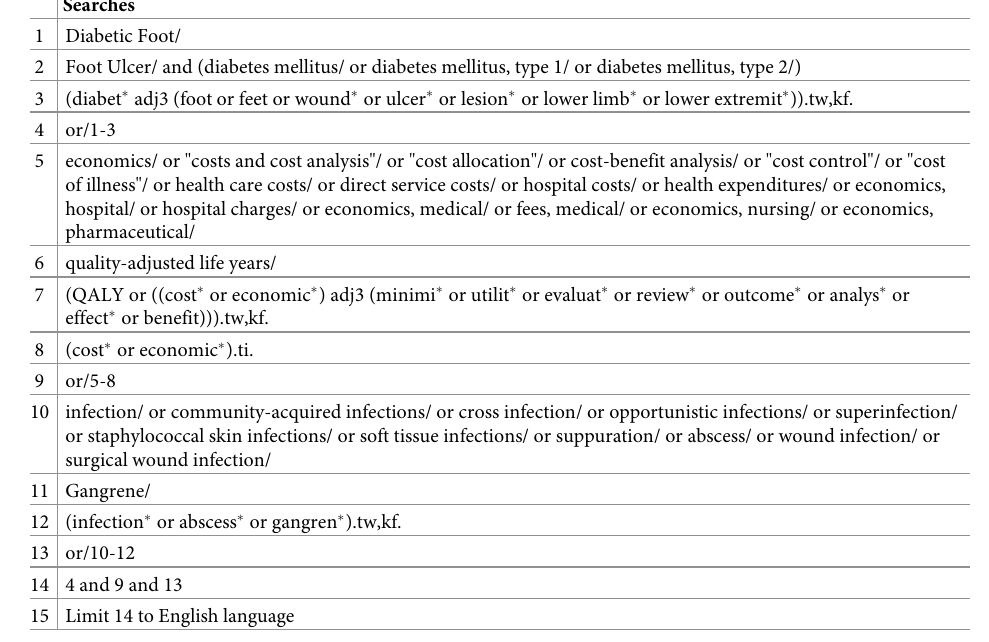
Table 1. MedLine (via Ovid) search strategy adapted for use in other databases.